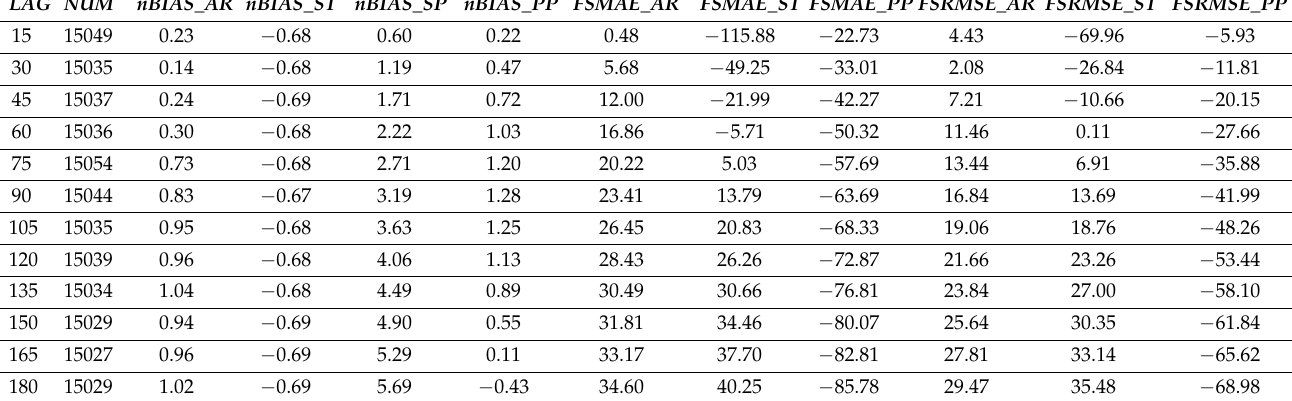
Table 5. Normalised BIAS and forecast skill related to MAE-FSMAE and RMSE-FSRMSE for plant P1 from 15 min up to three hours ahead.